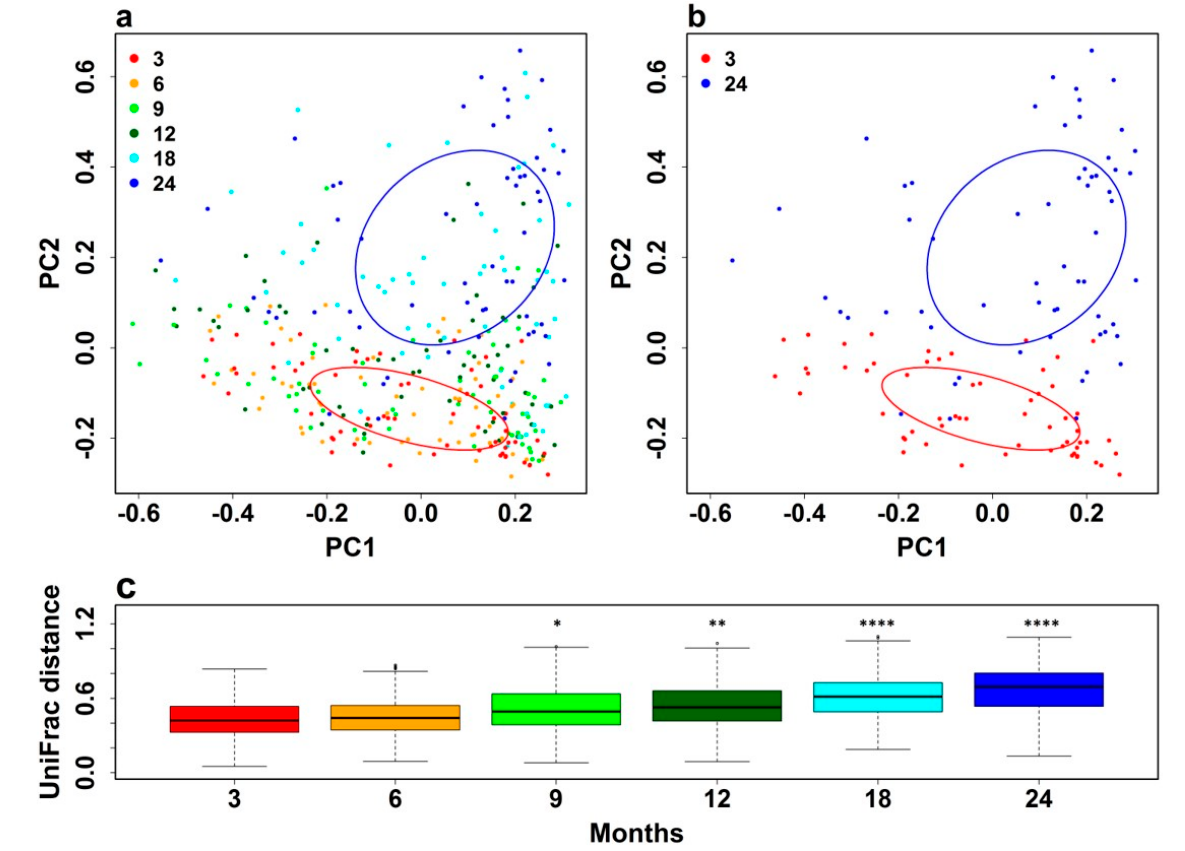
Figure 2. Beta diversity of the gut microbiota of all children: Beta diversity of the gut microbiota of all children was assessed using principal coordinates analysis (PCoA) of weighted Unifrac distances: ( a ) at 3-monthly intervals from 3 to 24 months and ( b ) at 3 and 24 months. ( c ) Comparison of weighted UniFrac distances at 6, 9, 12, 18, and 24 months compared with 3 months of age was determined using the ellipse R package, which was used to generate 95% confidence intervals. Differences were determined using Adonis with 1000 permutations in the vegan R package with Bonferroni correction. * p < 0.05, ** p < 0.01, **** p < 0.001.